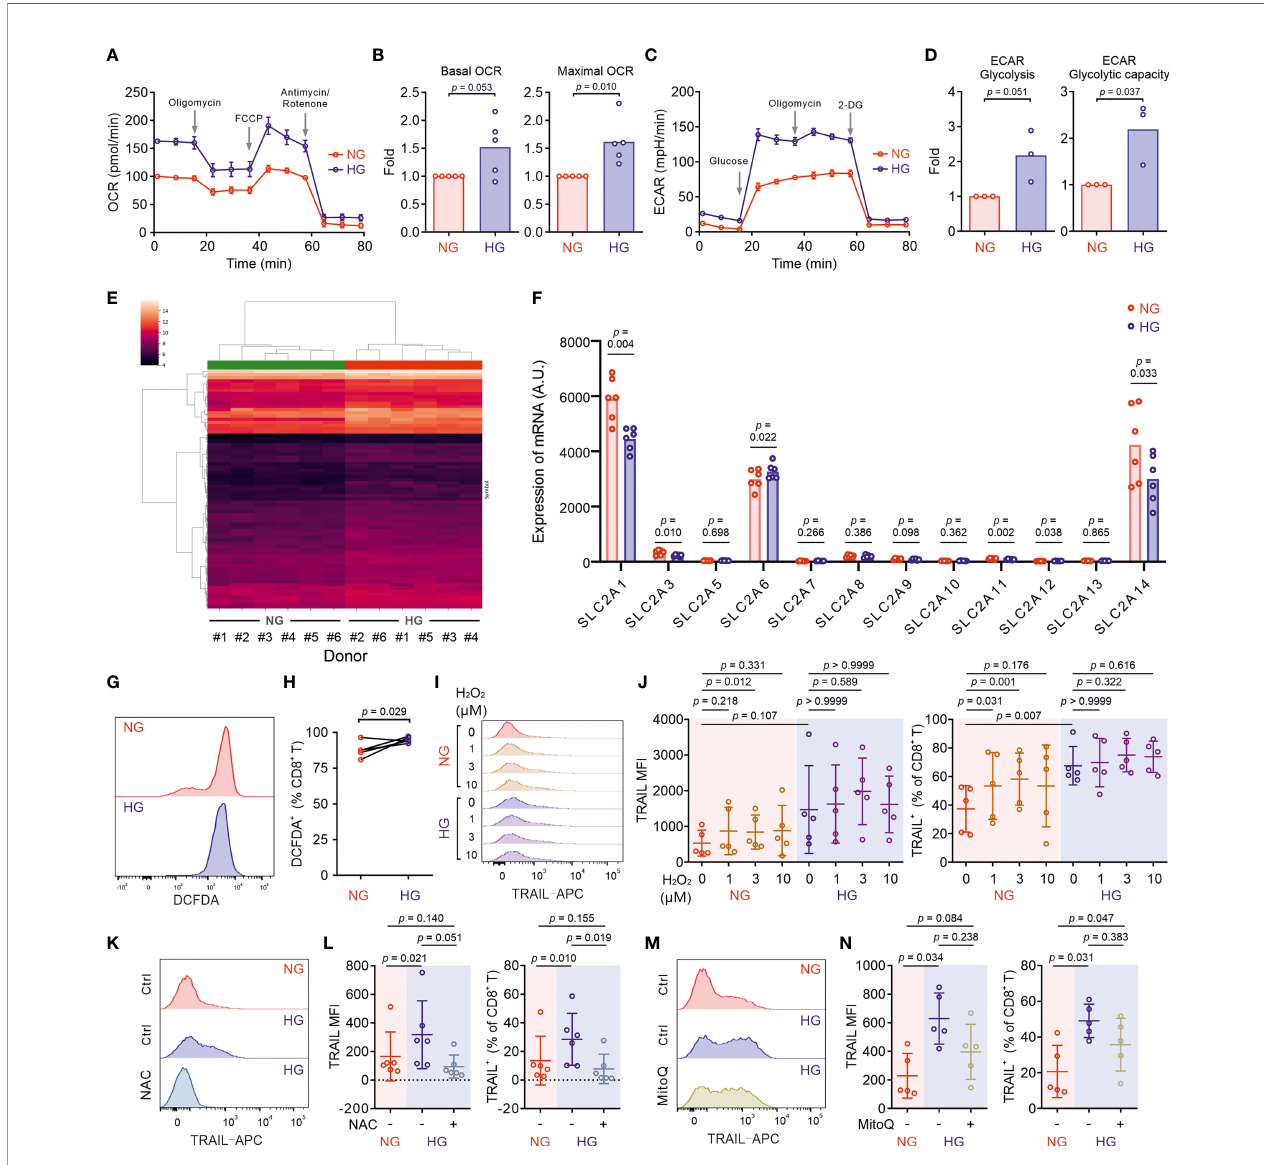
FIGURE 3 | Metabolic processes in CTLs are reprogrammed by high glucose. Primary human CD8 + T cells were stimulated with CD3/CD28 beads for 3 days in NG (5.6 mM) or HG (25 mM) medium. (A – D) Oxidative phosphorylation (n = 5 donors) and glycolysis (n = 3 donors) of CTLs from two independent experiments were determined with seahorse assay. One representative donor for oxidative phosphorylation and glycolysis is shown in (A, C) , respectively. (E) Heatmap of log2-transformed gene expression data. The microarray data was normalized using quantile normalization. Duplicate probes for genes were aggregated by taking the median intensity. Genes were fi ltered for those with an absolute fold change > 1.5, and a Benjamini-Hochberg adjusted p -value < 0.05. (F) Expression of glucose transporters at mRNA level from the transcriptomics data ( Table S1 ) of 6 donors collected from fi ve independent stimulations and two independent microarray analyses. A.U. stands for arbitrary units. (G, H) ROS production in CD8 + T cells was determined at 6 hours after CD3/CD28 bead stimulation by DCFDA (n = 5 donors from three independent experiments). One representative donor is shown in (G) Connected lines in (H) are the data from the same donor. (I, J) H 2 O 2 enhances TRAIL expression in CTLs in NG. CD8 + T cells were stimulated with CD3/CD28 beads in presence or absence of H 2 O 2 for 3 days (n = 5 from three independent experiments). One representative donor is shown in (I, K – N) Inhibition of ROS production abolishes HG-enhanced TRAIL expression in CTLs. NAC ( K , L , 10 mM, n = 6 donors) or MitoQ ( M, N , 0.4 m M, n = 5 donors) from three independent experiments was added during the activation for 3 days. One representative donor for NAC and MitoQ is shown in (K, M) , respectively. Results are represented as Mean ± SD. Data were analyzed by two-tailed unpaired Student ’ s t test (B, D) , two-tailed paired Student ’ s t test (H) or one-way ANOVA with Bonferroni ’ s multiple comparison test (J, L, N)